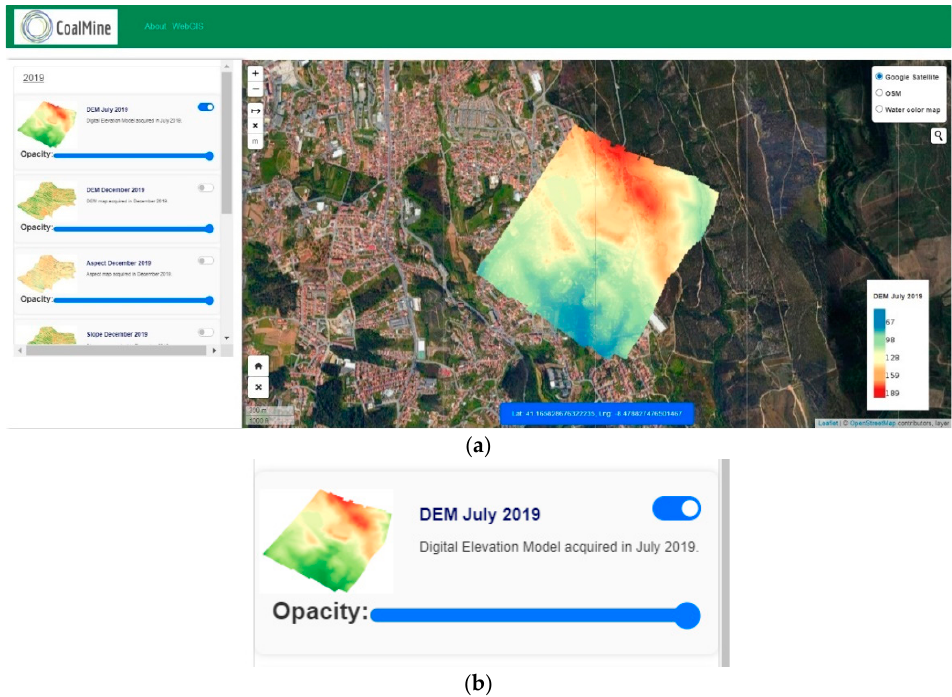
Figure 7. ( a ) WebGIS application and ( b ) detail of the cards where the map can be turned on/off. The maps were generated in raster format, except for water and soil samples, which were created in vector format (points). In these two layers, an additional functionality was applied. At each point, when clicked by the user, a table appears with the information on the hydrogeochemical and soil characterization [20], along with the geographical coordinates of each point (Figure 8). In the future, the webGIS will be continuously maintained and updated when new data are collected. In the About link, all the information about the data and procedures, as well as the contacts, are